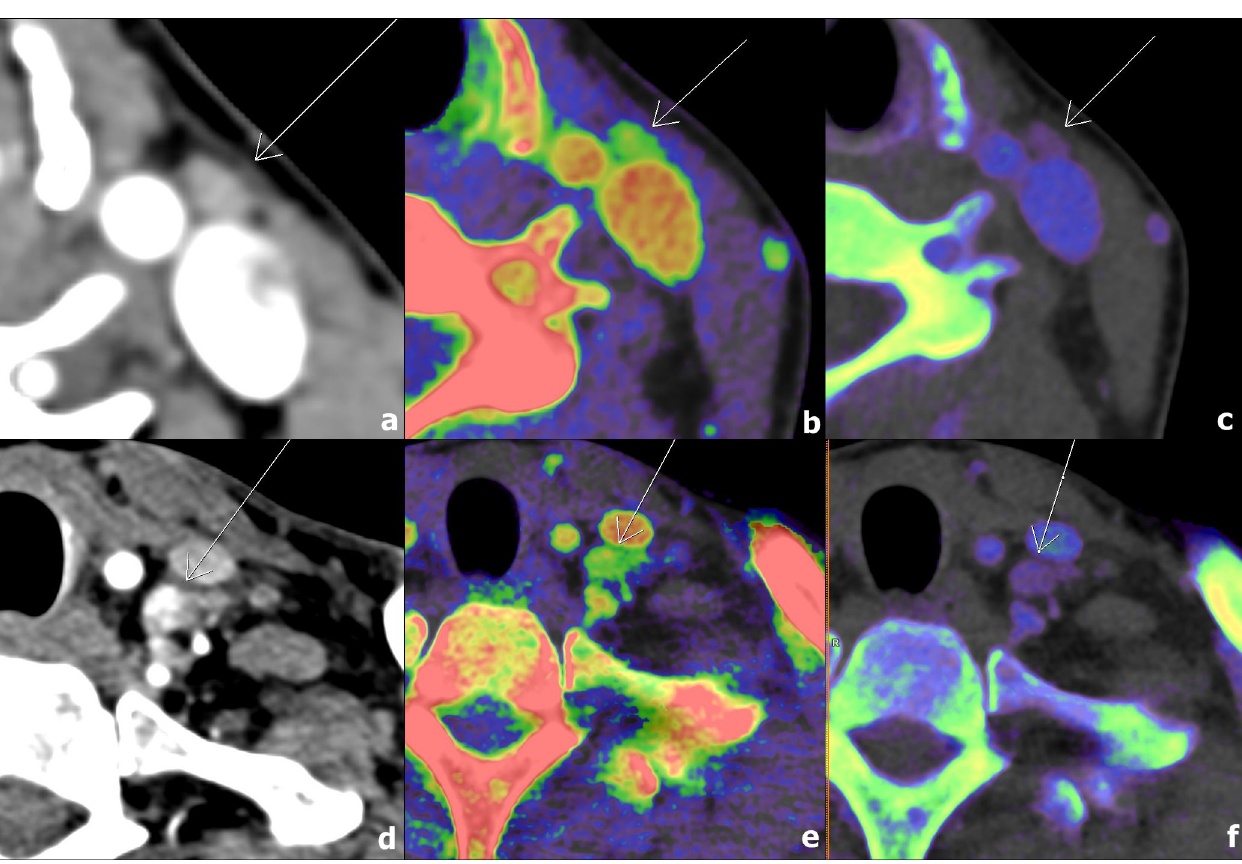
Fig 2. Axial CT images of arterial phase (a, d), DECT-derived contrast-enhancement (b, e), and Rho/Z (c, f) maps of two patients with papillary thyroid carcinoma. A 47-year-old female patient with a benign lymph node at left cervical level II (a, b, c; AUC 100keV = 36.7, HU arterial = 0.32, Z eff = 0.91, CM = 0.58, IC = 0.56, λ HU = 4.7), and a 53-year-old male patient with a metastatic lymph node at left cervical level IV (d, e, f; AUC 100keV = 43.5, HU arterial = 0.41, Z eff = 0.93, CM = 0.62, IC = 0.58, λ HU =